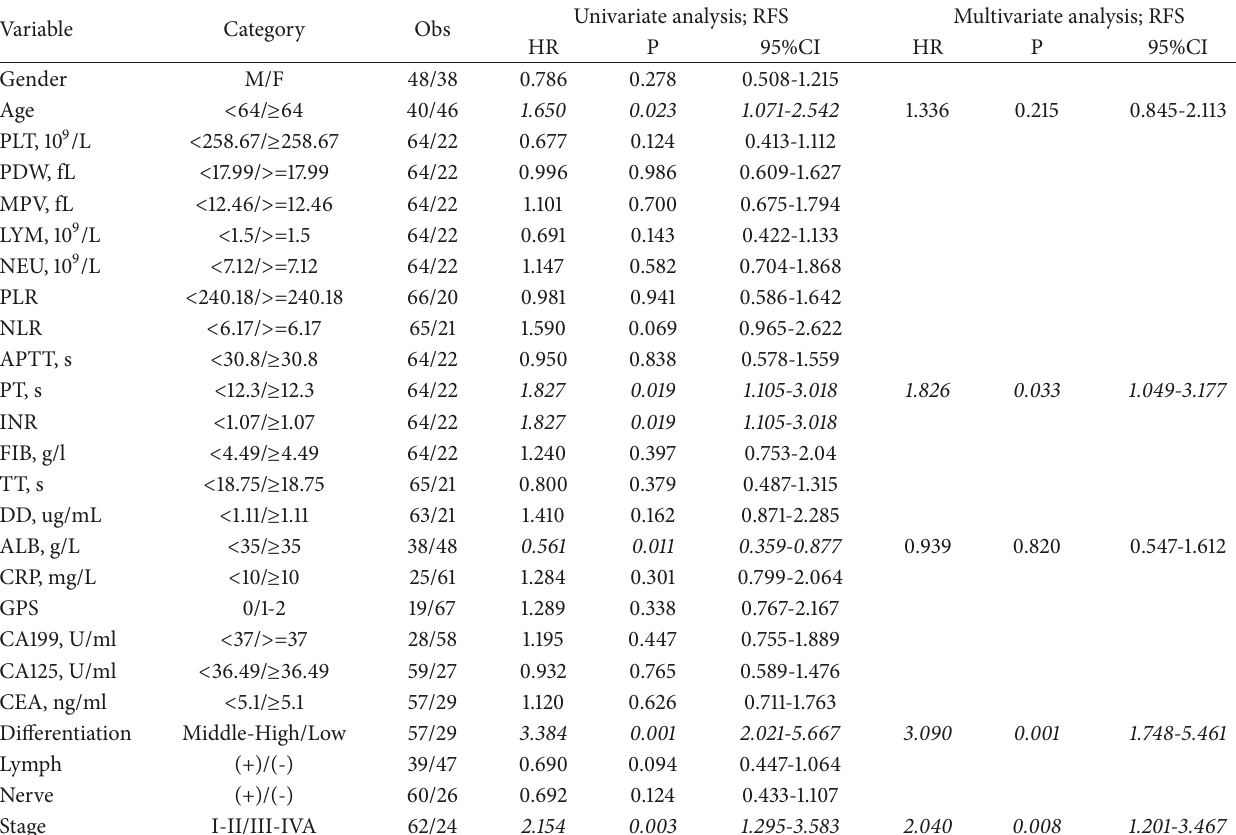
Table 3: Univariate and multivariate analyses of relationship between various clinical factors and recurrence-free survival (RFS).